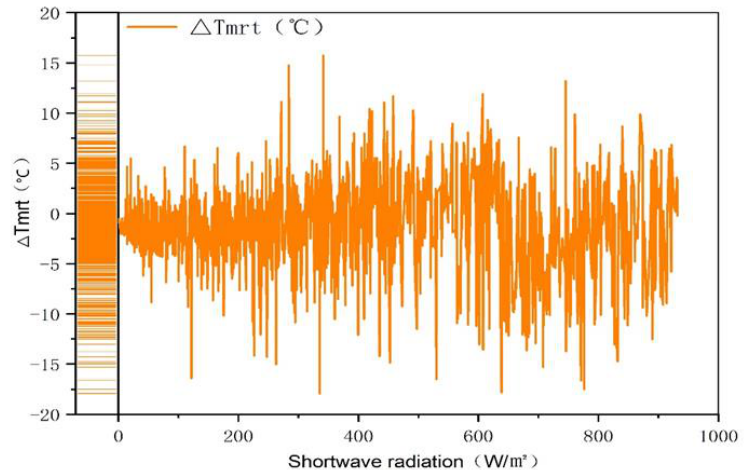
Figure 5. ΔTmrt in different shortwave radiation ranges. Figure 5. ∆ Tmrt in different shortwave radiation ranges.